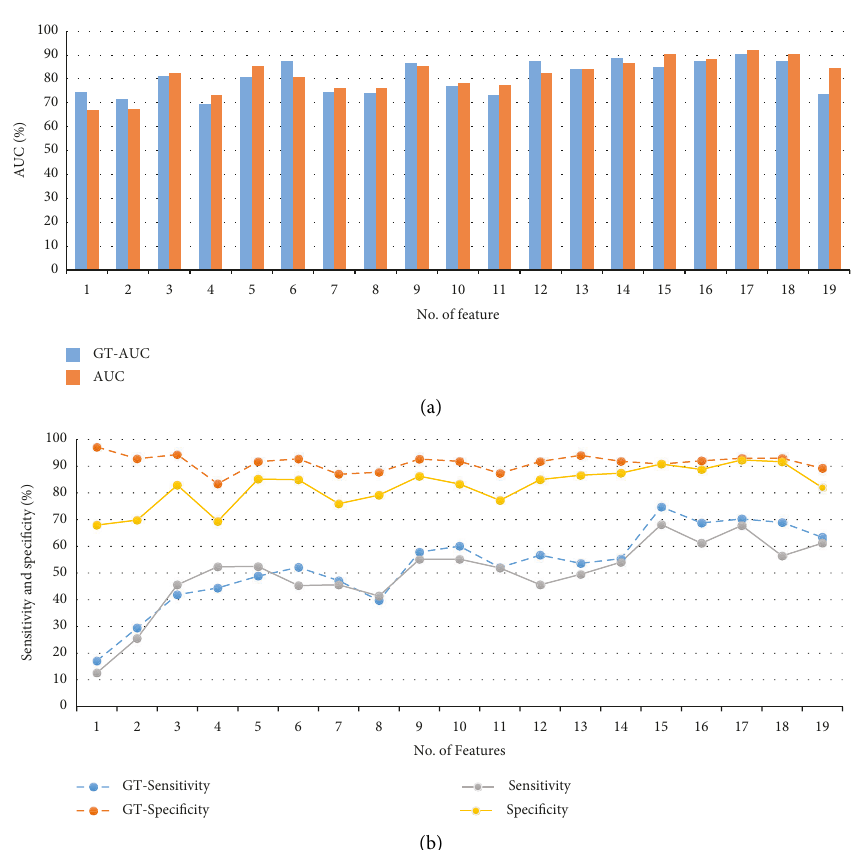
Figure 4: AUC, sensitivity, and specificity results. (a) AUC recorded for GT Data and Forecasted Data and (b) sensitivity and Specificity recorded on GT Data and Forecasted Data.